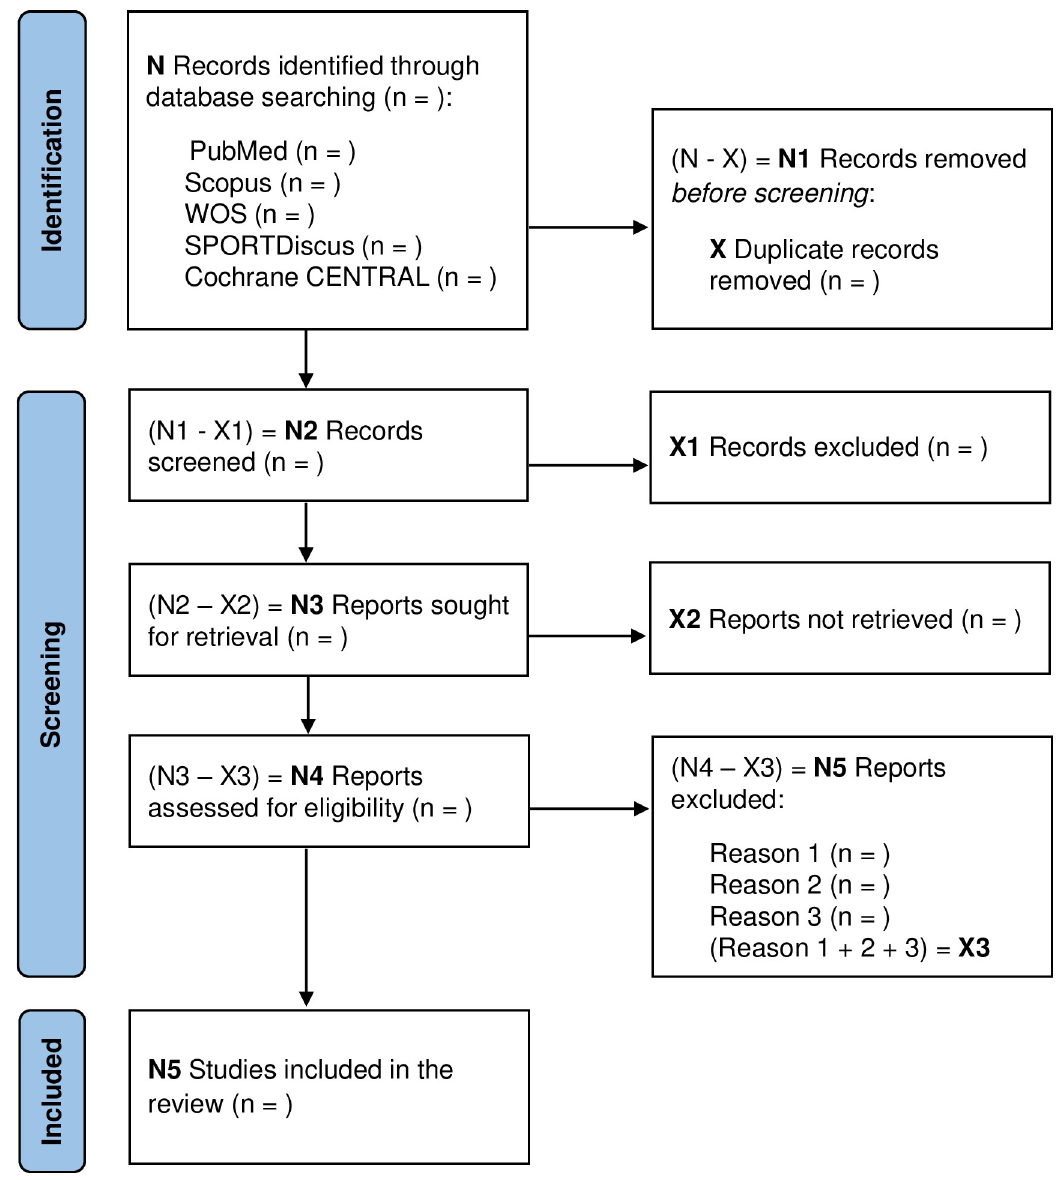
Fig 1. PRISMA flow diagram for identifying, screening, and determining the eligibility and inclusion of